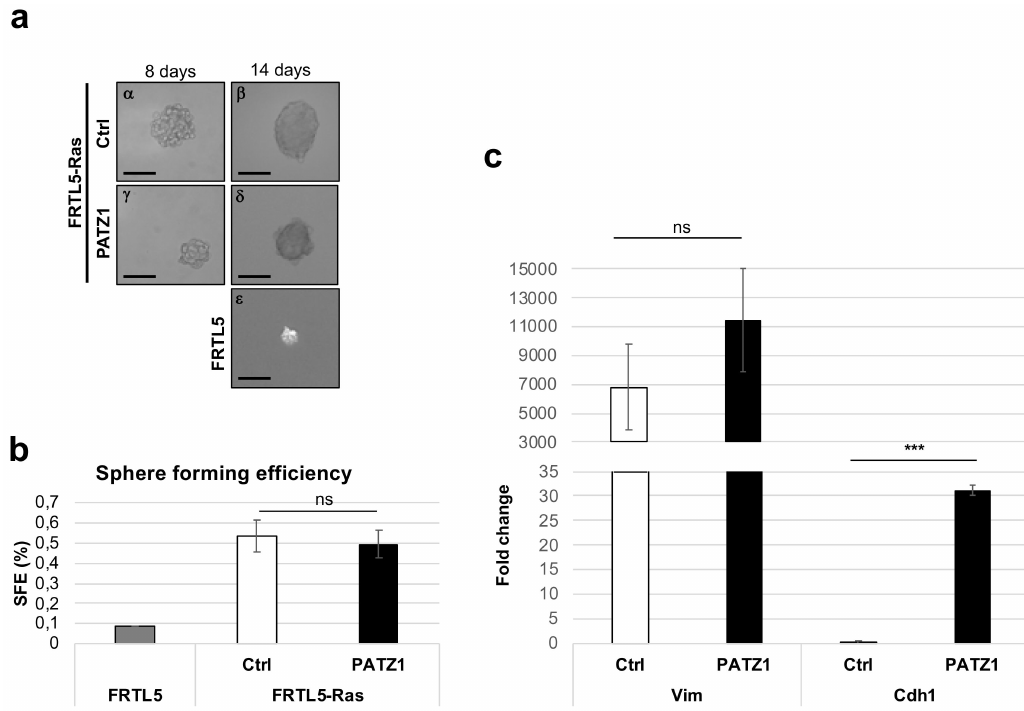
Figure 2. Thyrosphere formation in rat thyroid cells. ( a ) Representative images of P0 thyrospheres obtained from FRTL5-Ras-Ctrl, FRTL-Ras-PATZ1, and FRTL5 cells, at 8 and 14 days post plating in stem cell medium. Scale bars: 100 µ m; ( b ) sphere forming efficiency calculated at 14 days post plating cells in stem cell medium. No significant differences were observed between FRTL5-Ras- PATZ1 and FRTL5-Ras-Ctrl cells. The graph expresses the mean values of three independent experiments performed in two different clones for either Ctrl or PATZ1 cells. FRTL5 untransformed cells were used as negative control in one experiment performed in duplicate. ( c ) qRT-PCR analysis of Vimentin ( Vim ) and E-cadherin ( Cdh1 ) gene expression in thyrospheres from FRTL5-Ras-Ctrl and FRTL-Ras-PATZ1 cells. The data shown express the mean values ± standard error (SE) of three independent experiments performed in triplicate, and, relative to the levels of Cdh1 expression in control thyrospheres. ns, not significant; ***, P < 0.001 as assessed by unpaired t